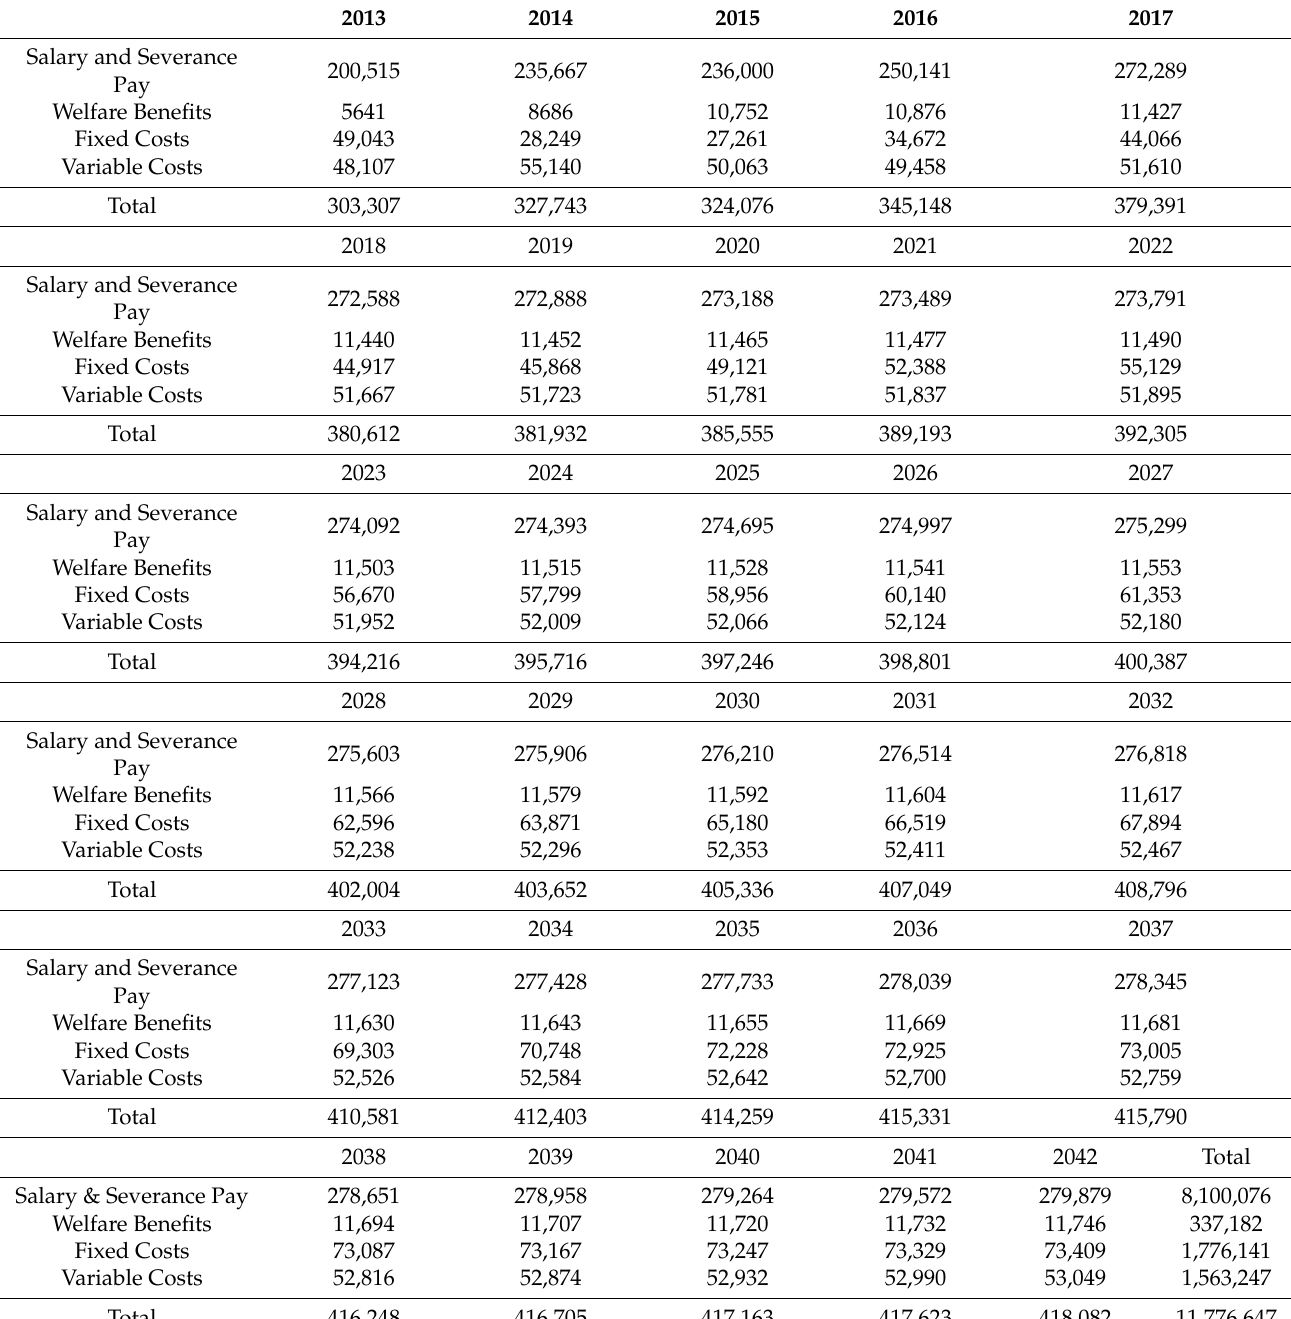
Table 9. Estimated SG&A expenses for 30 years (unit: U.S.